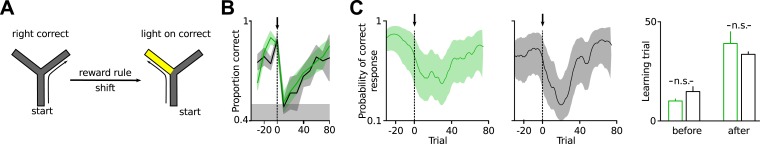
Extra-dimensional rule-shifting task in the y-maze.(A) Mice were food-restricted and learned to forage in a y-maze. Then, they learned the first reward rule (right arm correct). In each trial, one randomly chosen arm of the two possible target arms was illuminated. Once the animals had learned the spatial rule, the reward regime was changed to ‘light on’ (extradimensional shift, n = 6, 5). (B) Normalized correct trials are plotted against trial number. Arrow at t = 0 indicates the reward rule change. Both groups of mice learned the initial spatial rule as well as the rule change. Data are binned over 10 runs. (C) Examples of individual learning curves of a Disc1 and a control mouse with 95% confidence intervals. The trial in which the lower confidence interval exceeded chance level was considered the first trial in which the animal had learned the task (learning trial). Right, identical learning trials of both rules in Disc1 and control mice. Data are mean ± SEM unless stated.